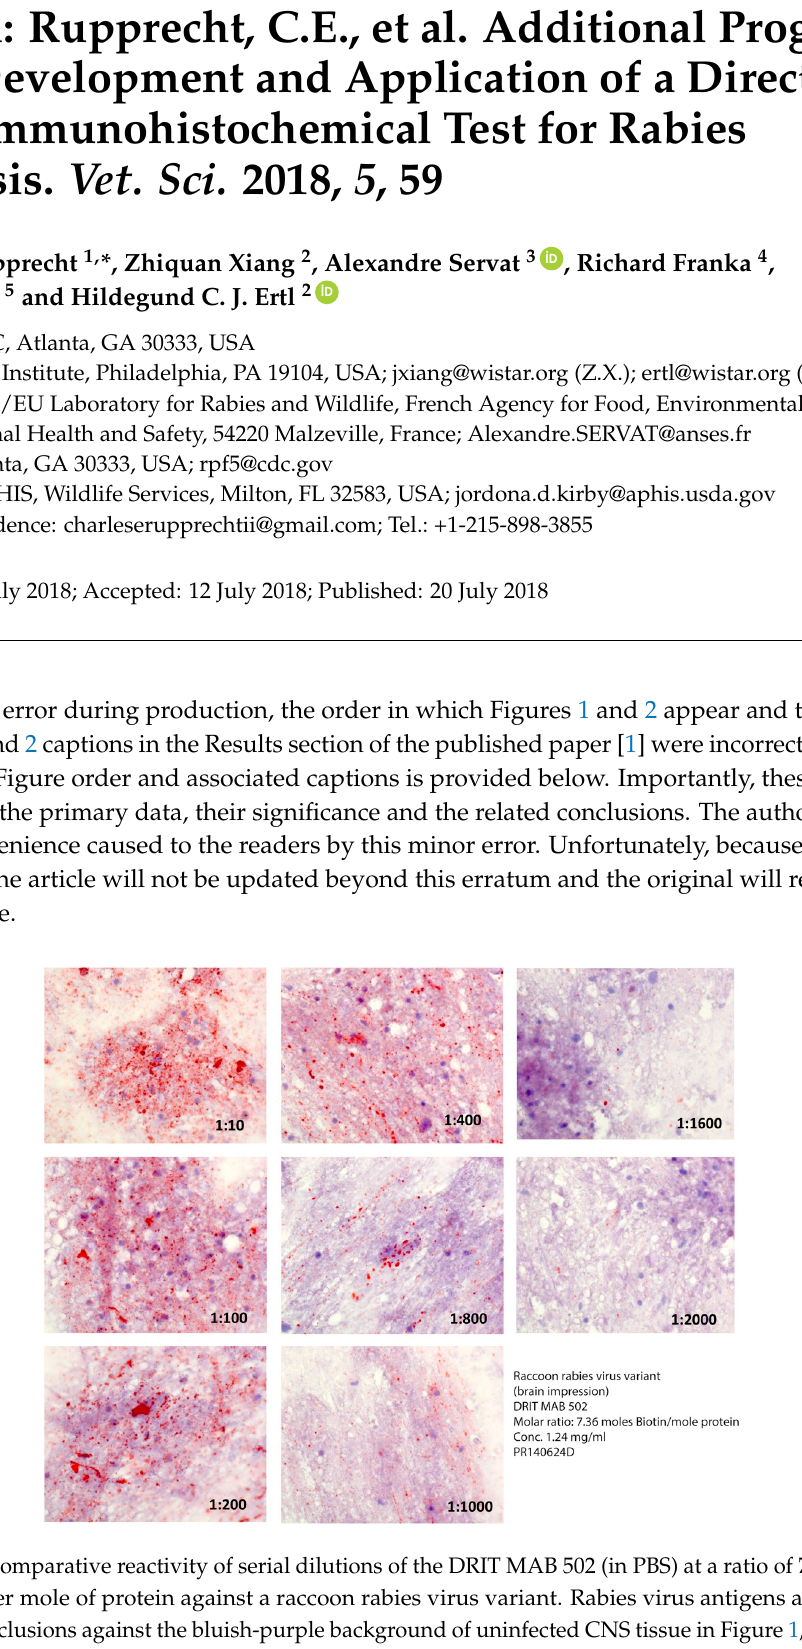
Figure 2. Comparative reactivity of serial dilutions of the DRIT MAB 502 at a ratio of 3.9 moles of biotin per mole of protein against a raccoon rabies virus variant.